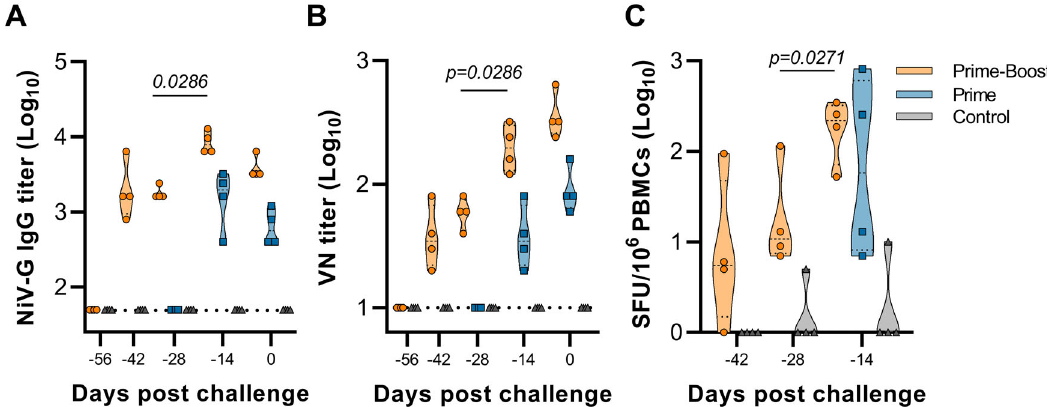
Fig. 1 Vaccination with ChAdOx1 NiV in AGMs induces humoral and cellular immune responses. A Truncated violin plot shows evidence of NiV-G-speci fi c IgG in serum at the indicated days post challenge in animals receiving intramuscular ChAdOx1 NiV via a prime-boost (orange, N = 4) or prime-only regimen (blue, N = 4), or ChAdOx1 GFP via a prime-boost regimen (gray, N = 4). B Truncated violin plot of neutralizing antibodies in serum are shown. C Truncated violin plot of NiV-G protein-speci fi c T-cell responses in PBMCs isolated from vaccinated or controls animals at indicated time points minus − 56 days post-challenge response. SFU spot-forming units. Black lines indicate median; dotted lines in violin plots indicate quartiles. The dotted line shows the limit of